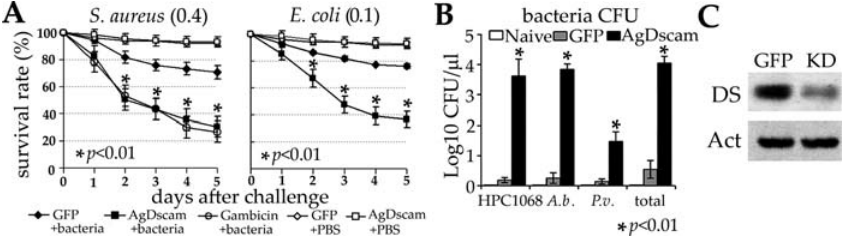
Figure 2. AgDscam Is Implicated in Anti-Bacterial Defense (A) RNAi-mediated depletion of AgDscam with a dsRNA fragment complementary to a non-spliced AgDscam exon resulted in decreased mosquito survival after challenge with S. aureus and E. coli compared to the challenged control GFP dsRNA -treated (GFP) mosquitoes. AgDscam dsRNA- treated mosquitoes with a significant decrease in survival compared to GFP dsRNA- treated (GFP) mosquitoes, according to a 2-way ANOVA ( p , 0.01), are indicated with asterisks. A Kaplan Meier survival analysis of GFP dsRNA- and AgDscam dsRNA- treated mosquitoes is presented in Figure S3. PBS-injected GFP dsRNA- and AgDscam dsRNA- treated mosquitoes ( ‘‘ GFP þ PBS ’’ and ‘‘ AgDscam þ PBS ’’ ) did not exhibit significant mortality. The survival rates of AgDscam dsRNA- treated mosquitoes and Gambicin dsRNA -treated mosquitoes after injection with Gram-positive bacteria (S. aureus) were similar. (B) RNAi-mediated depletion of AgDscam in absence of experimental bacterial challenge resulted in a proliferation of opportunistic bacteria in the mosquito haemolymph at 4 d after dsRNA injection, compared to non-treated mosquitoes (naı¨ve) and control GFP dsRNA- treated mosquitoes (GFP). The proliferating bacterial species, capable of growing on LB agar, were determined as species closely related to Bacterium HPC1068, Asaia bogorensis (A.b . ), and P. veronii (P.v.). The total number of bacteria isolated from the haemolymph is indicated with a separate bar (total). (C) Western analysis of AgDscam RNAi-treated 4-d-old female mosquitoes (KD) (mosquito) showed decreased AgDscam protein (DS) by approximately 50% compared to dsGFP -treated control (GFP). Total protein was extracted 4 d after dsRNA injection and normalized for equal actin (Act) content. DOI: